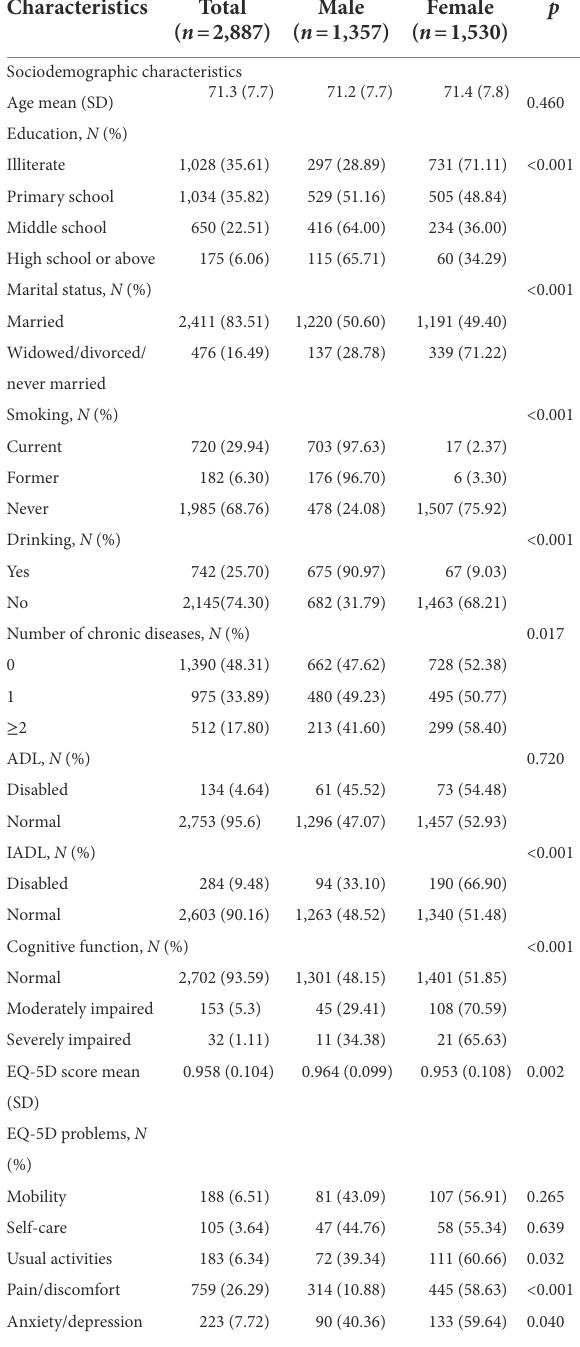
TABLE 1 Baseline characteristics of participants in The Liyang Study.